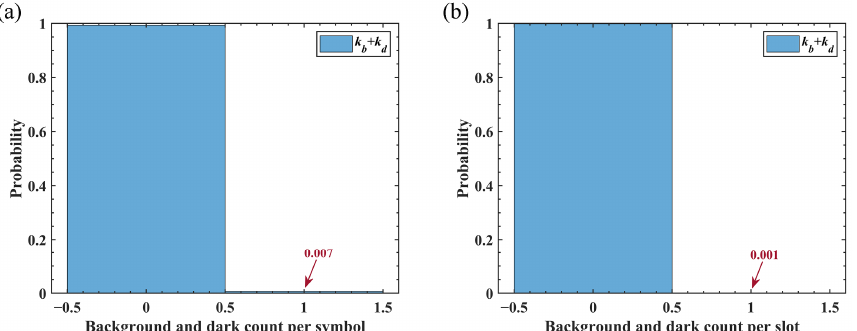
Figure 10. The measured background and dark count: ( a ) the histogram of background and dark counts per plot time (80 ns), ( b ) the histogram of background and dark counts per symbol time (2.56 µs).